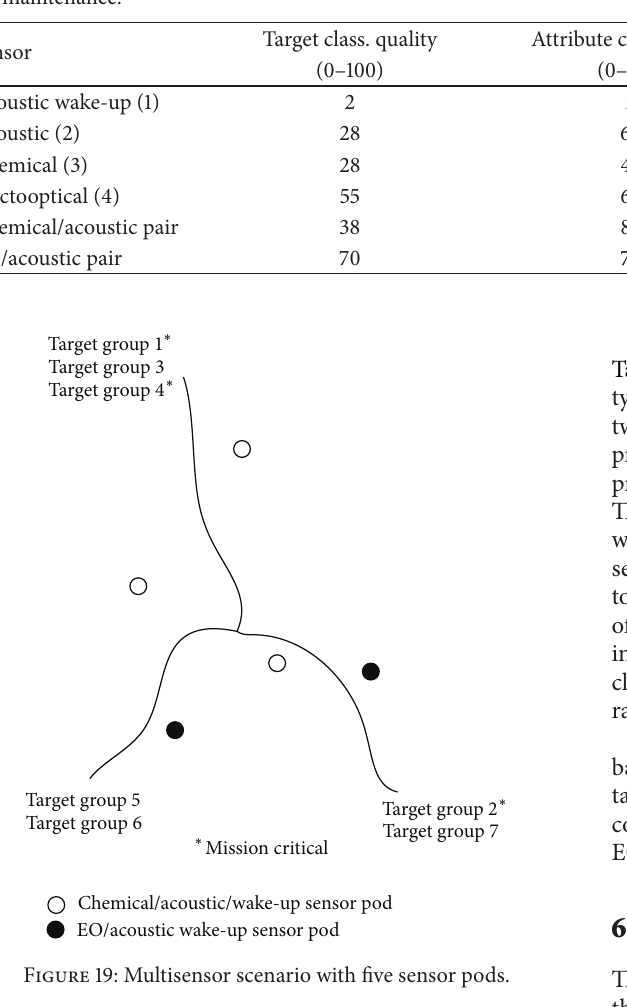
Table 3: Condition-based mapping of sensor capabilities to their fuzzy antecedent measurement function based on season and time from last maintenance.